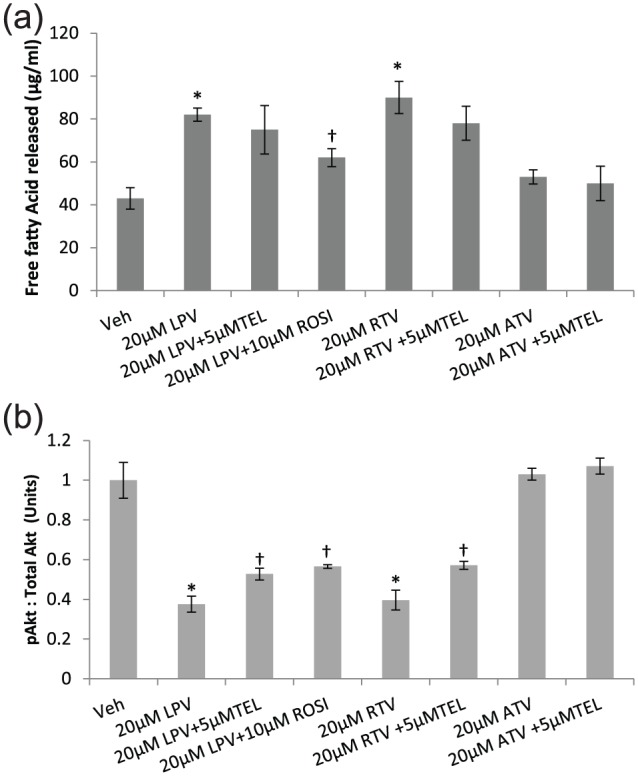
(a) Lipolysis and (b) expression of pAktSer473 in human
primary adipocytes following incubation with PIs with or without TEL or
ROSI. Data are expressed as mean (n = 3) ± SD. pAkt expression was
adjusted to total Akt and data are expressed as mean ratio of
absorbance. (*p < 0.01, drug vs vehicle;
†p < 0.01, drug vs drug + TEL or
drug + ROSI.).Veh: vehicle; RTV: ritonavir; LPV: lopinavir; ATV: atazanavir; TEL:
telmisartan; ROSI: rosiglitazone.